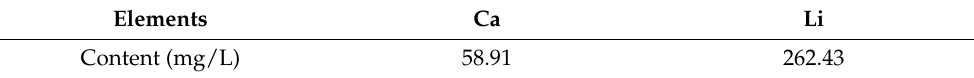
Table 2. Analyze the composition of the solution after oxalic acid and NaOH treatment. Elements